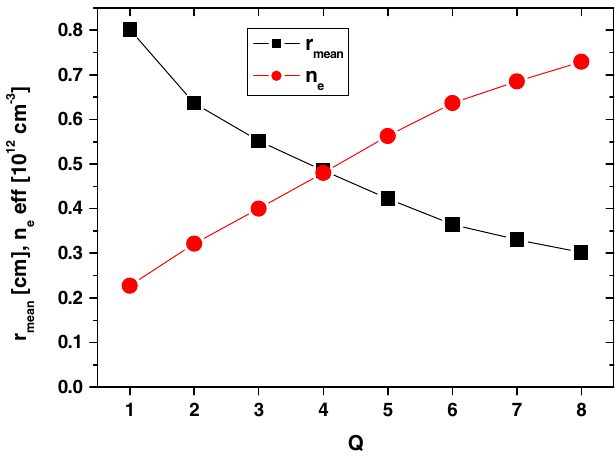
FIG. 7. (Color) Mean radius of the ion beam profile at the plasma electrode (squares) and the effective electron density (circles) for neon ions as a function of charge state.